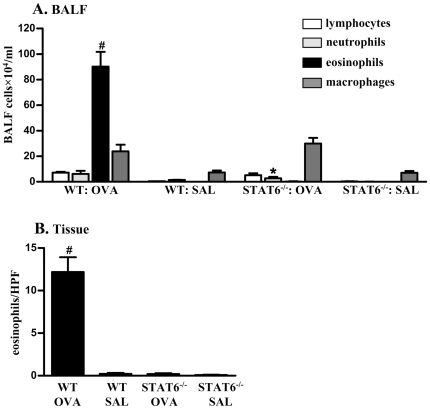
Characterization of eosinophilic inflammation in allergic lungs.OVA/OVA treated WT mice had significantly increased numbers of eosinophils in (A) BALF and (B) peribronchial and perivascular regions of the lung, compared to SAL/OVA treated controls. The levels of BALF neutrophil in OVA/OVA treated STAT6-deficient mice were significantly higher than that in SAL/OVA WT control but less than that in OVA/OVA treated WT mice. No significant infiltration of eosinophils was observed in OVA/OVA treated STAT6-deficient mice, which were at the same levels as SAL/OVA treated WT mice. #P<0.05 compared to SAL/OVA treated WT, *P<0.05 compared to OVA/OVA treated WT mice.